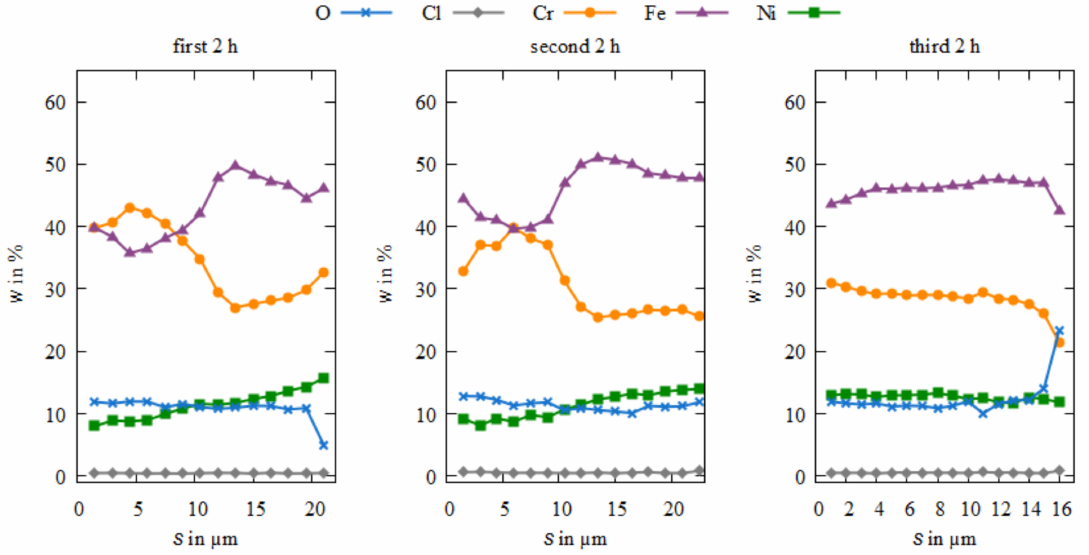
Figure 10. EDXS measurement of alloy compositions over the entire layer thickness of the DC 18 A/dm 2 samples depending on the electrolyte